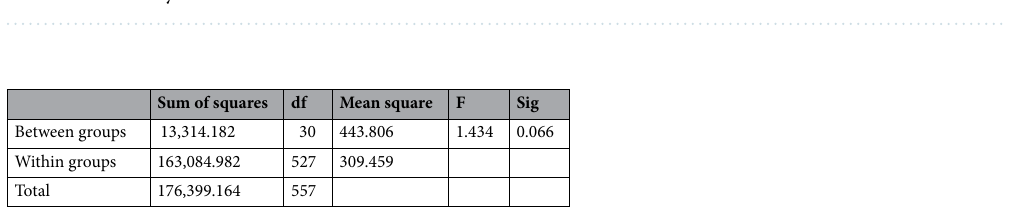
Table 3. One-way ANOVA for Titli latitude.